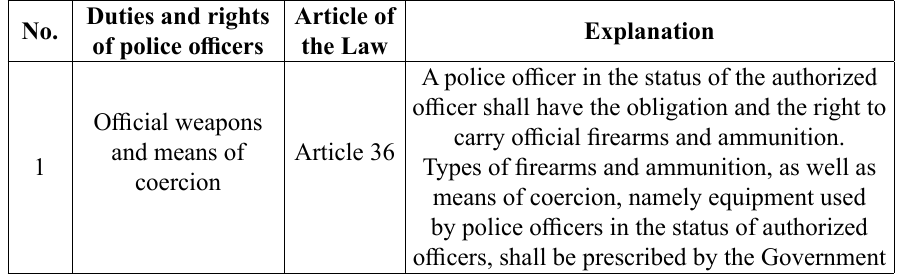
Table 3. Duties and rights of police officers in policing Duties and No.